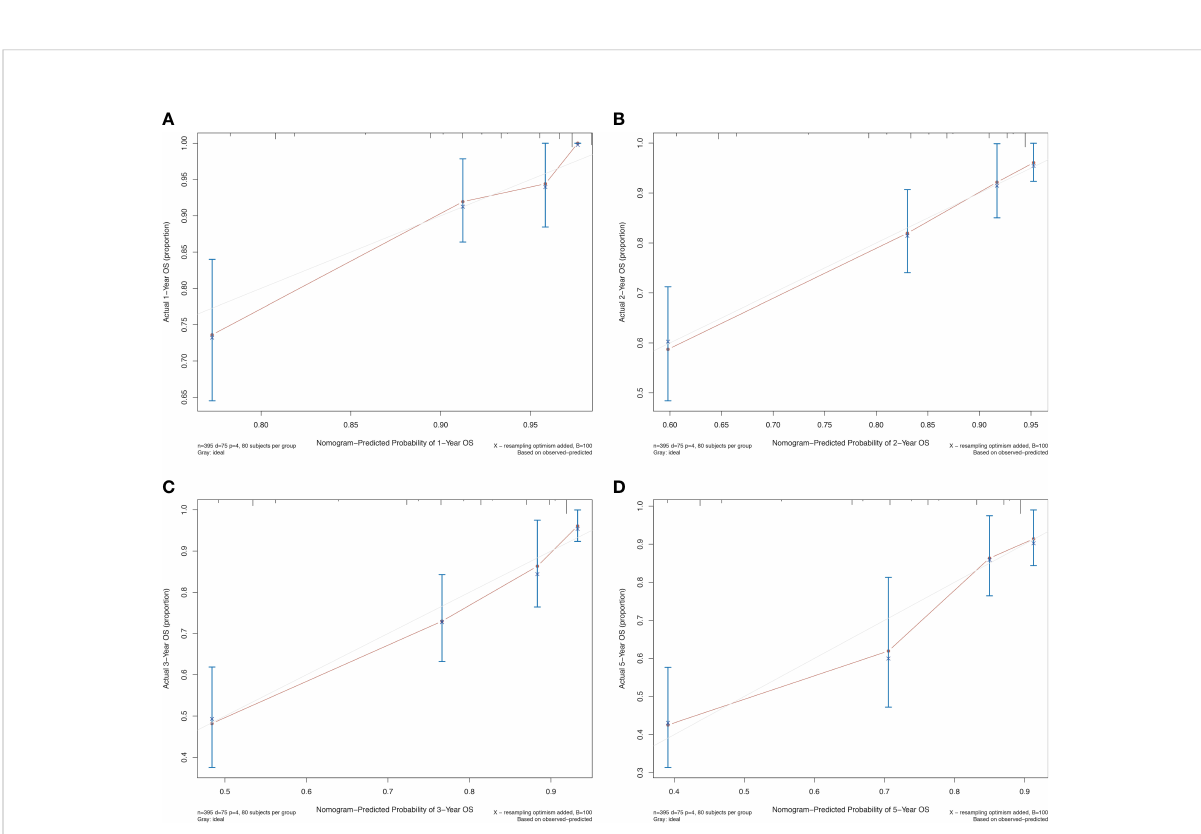
FIGURE 5 Calibration curve for the prognostic nomogram for patients with GISTs. (A) 1-year OS; (B) 2-year OS; (C) 3-year OS; (D) 5-year OS. OS, overall survival.